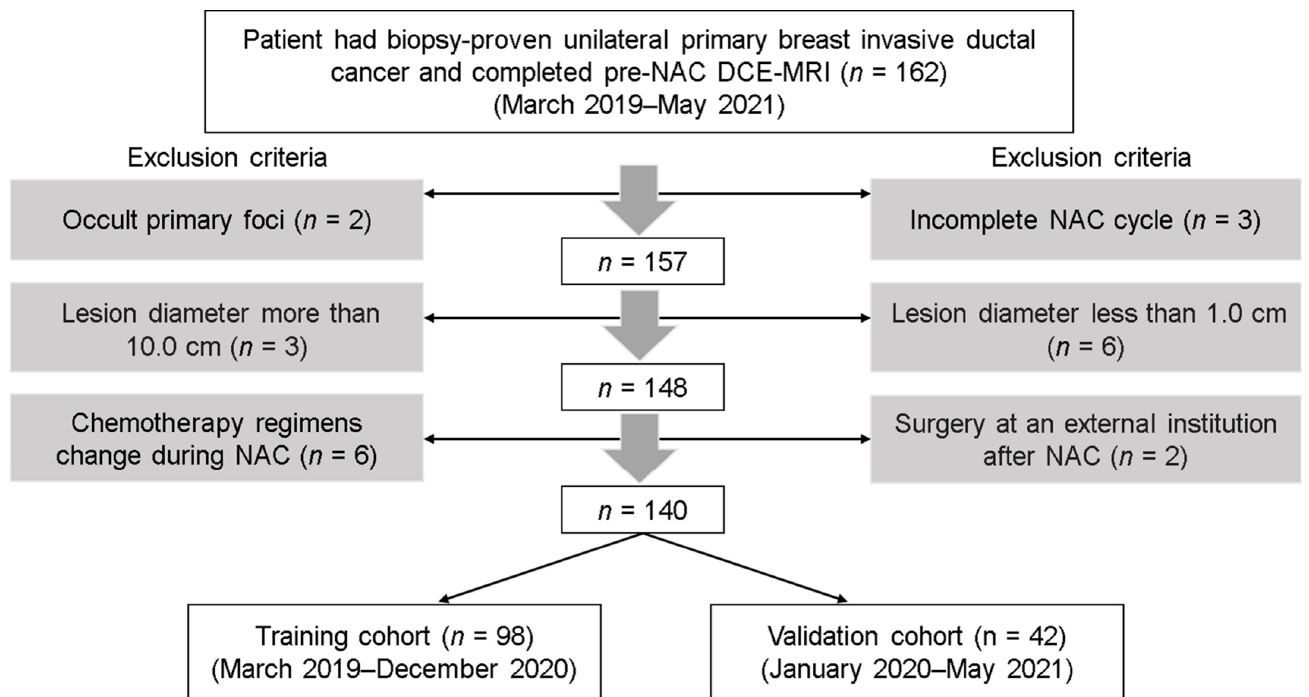
Figure 1. Flowchart of patient collection. NAC, neoadjuvant chemotherapy; DCE-MRI, dynamic contrast-enhanced.